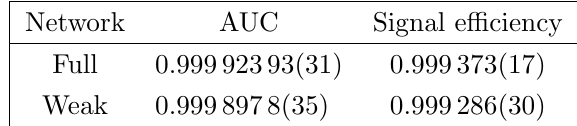
Table 3 . Metrics for training networks to distinguish gluino pair production with decays to 1st generation quarks from the dominant Z + jet background. The signal e(cid:14)ciency is given for a background acceptance of